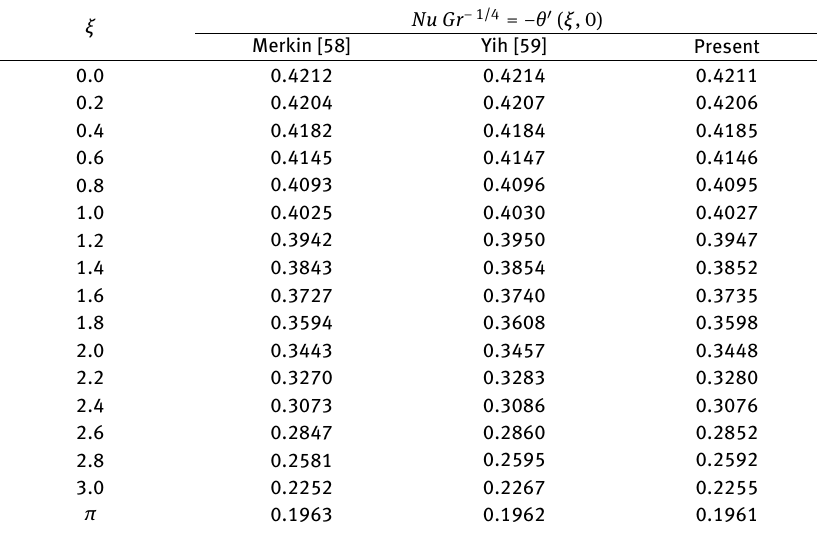
Table 1: The values of the Local heat transfer coefficient ( Nu ) for different values of ξ with Pr = 0.71, β → ∞ , Λ = 0, Da → ∞ and Nb = Nr = Nt = 0, Le = 0.6, M = 0.5